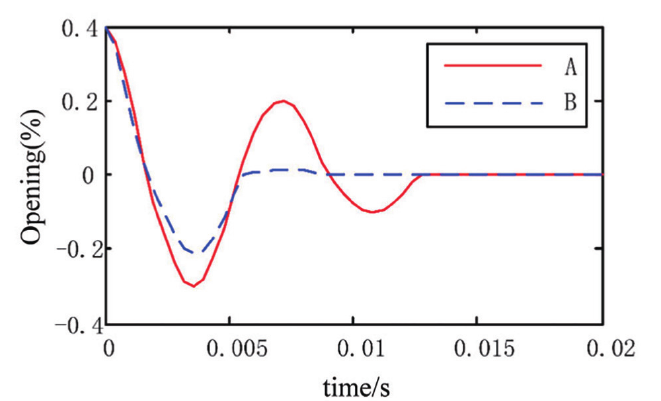
Figure 12. Valve position response under different valve position speeds.